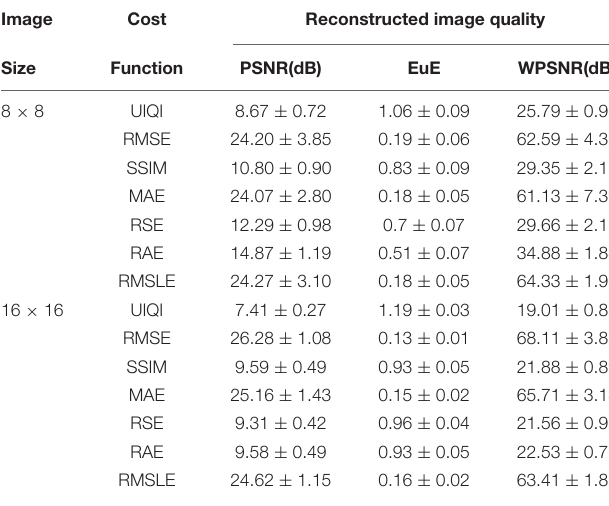
TABLE 3 | Comparison of cost functions for SA-based image reconstruction using performance measures: (PSNR, EuE, and WPSNR).